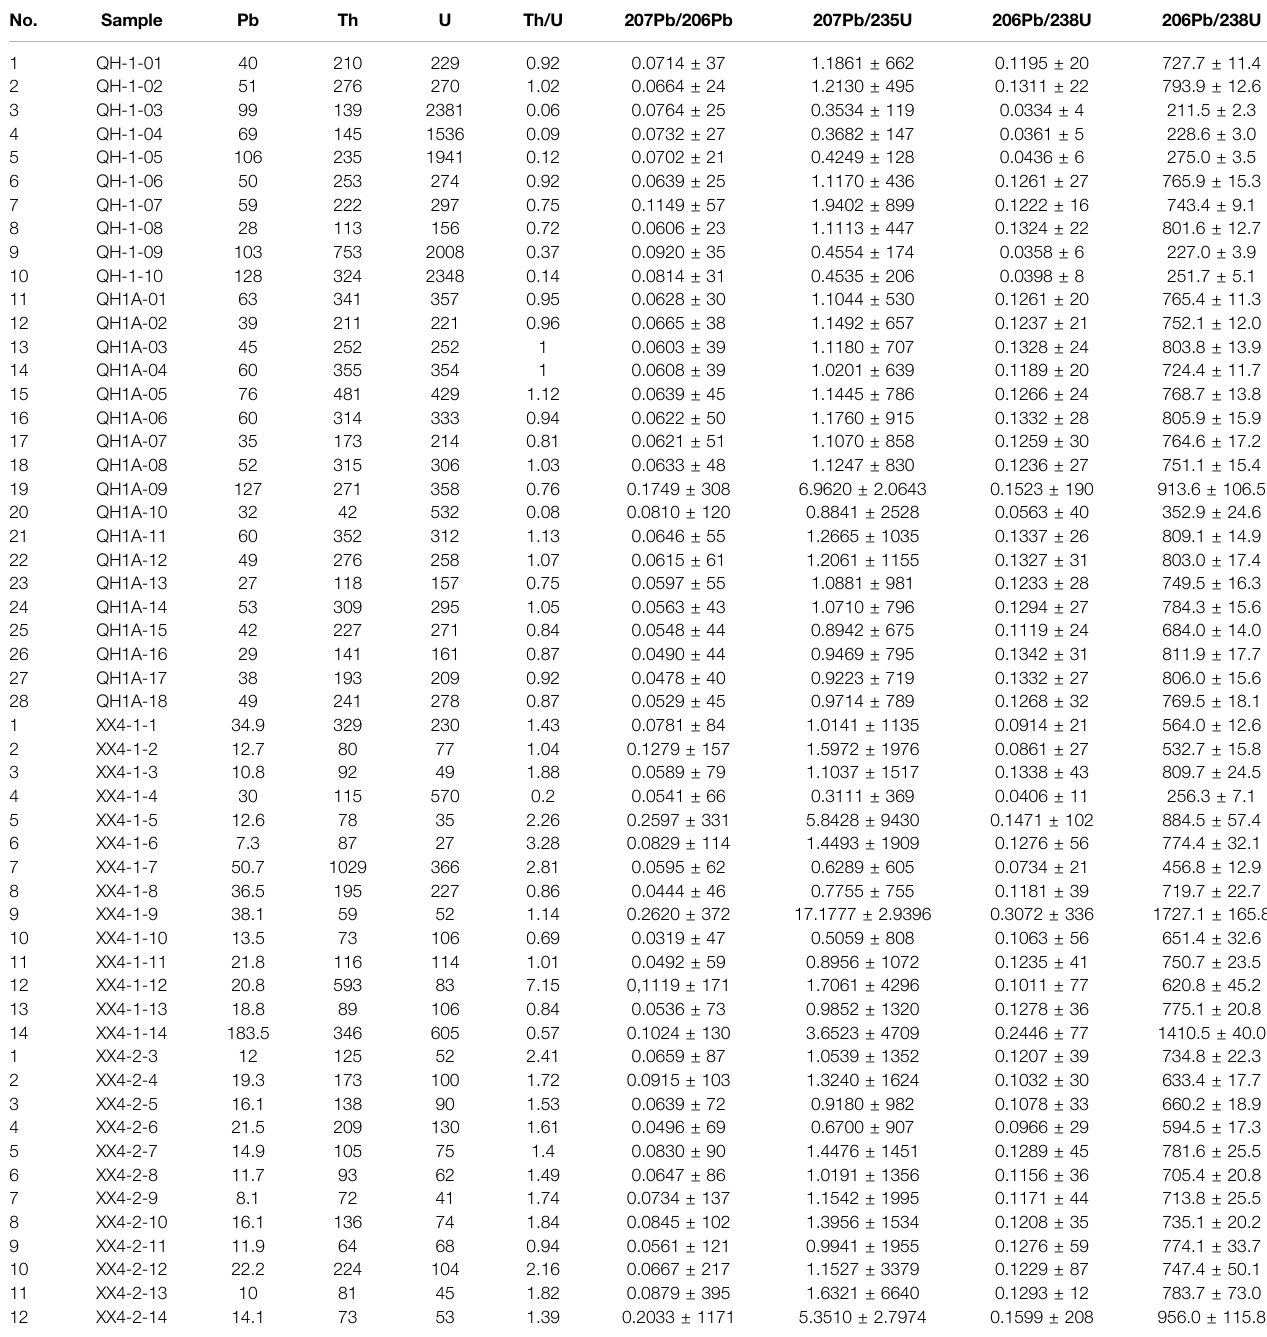
TABLE 2 | Zircon LA ICP MS U-Pb age data of Qianhe and Chengbei paragneisses in